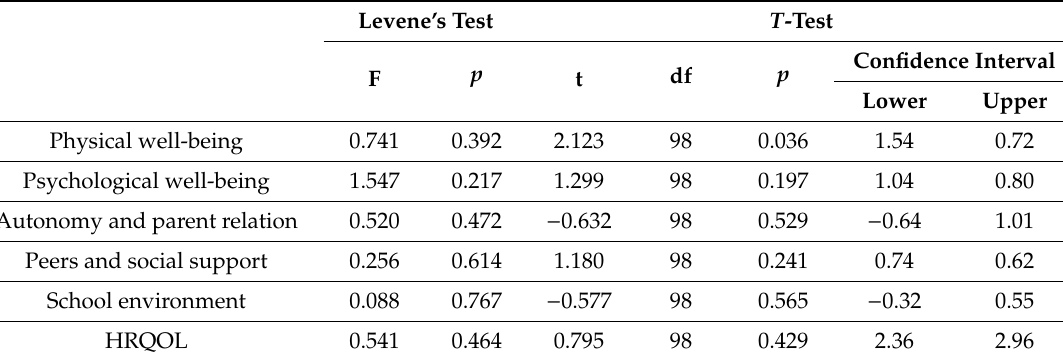
Table 6. T -test for independent